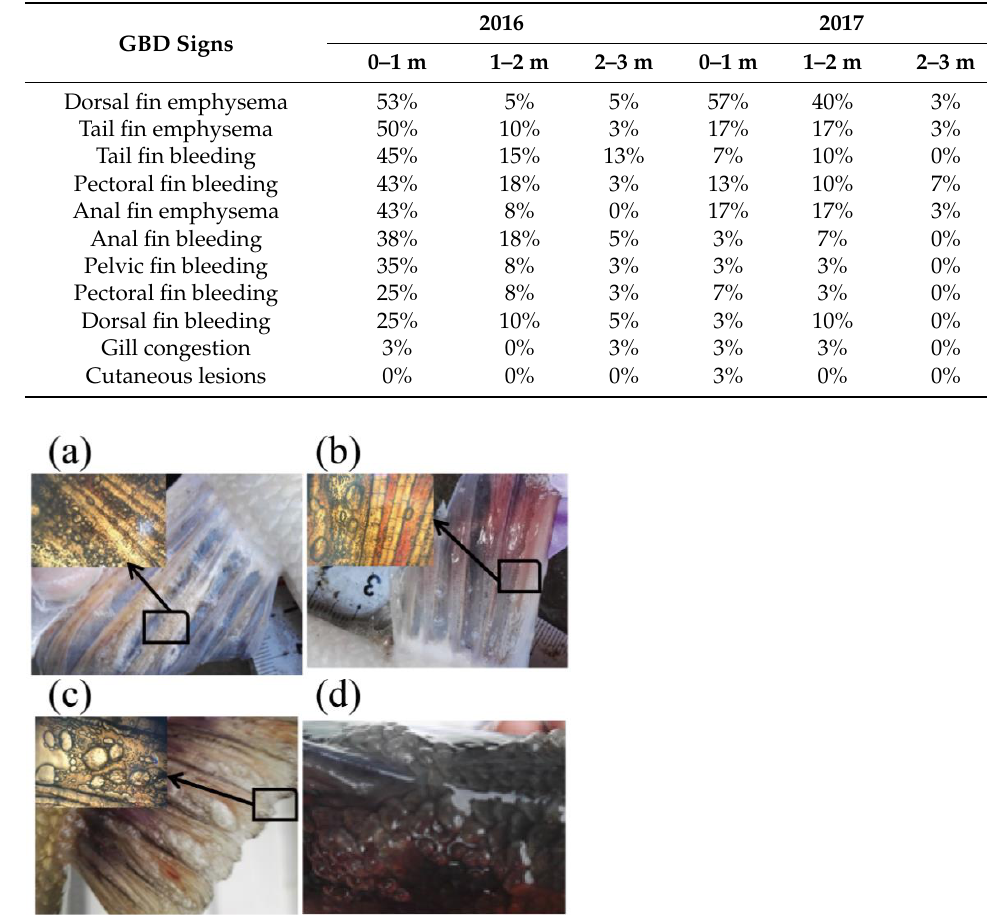
Table 1. Prevalence of S. prenanti with different GBD symptoms during the TDG supersaturation exposure experiments in 2016 and 2017; 40 adult S. prenanti were used in each scenario in 2016 while 30 adult fish were used in each scenario in 2017.